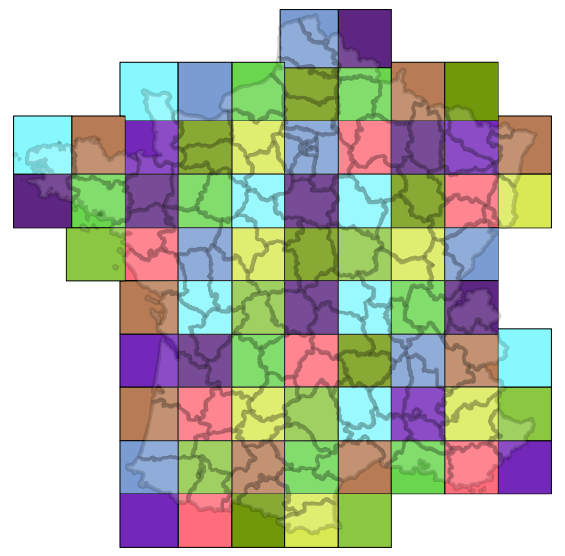
Figure 11. Tiled-based approach for classifier training. Each colour identifies the subset of tiles for which a common classifier is